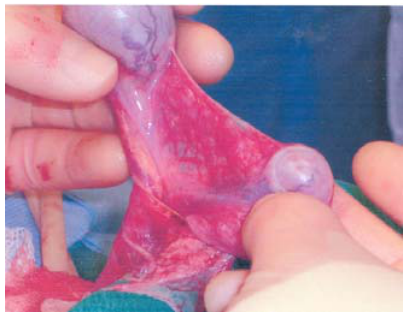
FIGURE 2 . Intraoperative appearance of supernumerary